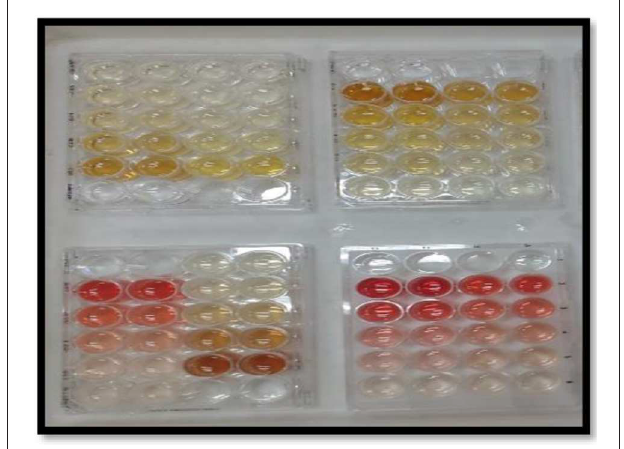
FIGURE 1 | Fungicidal activity against S. rolfsii of (2E)-1-ferrocenyl-3-(2,6-dichlorophenyl)-prop-2-en-1-one (3o) .